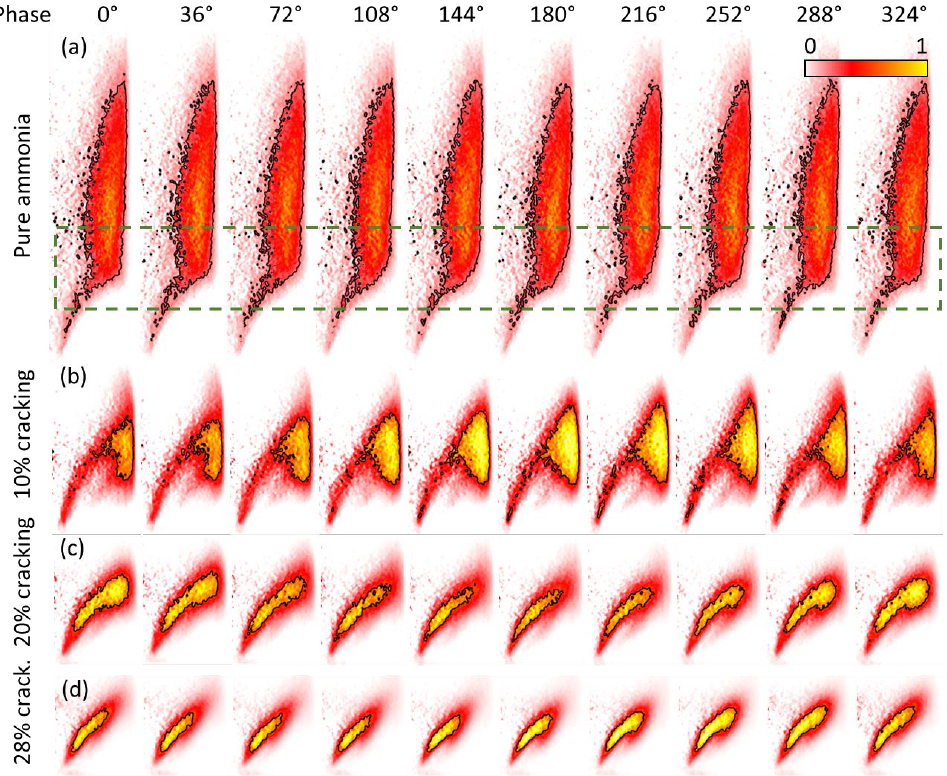
Figure 10. Phase-locked Abel-deconvoluted images of the OH* chemiluminescence for the four flames of Figure 1 (( a ) pure ammonia flame, ( b ) flame of ammonia at 10% cracking, ( c ) flame of ammonia at 20% cracking, and ( d ) flame of ammonia at 28% cracking), subjected to acoustic forcing at 192 Hz, with a forcing amplitude of 10%. The black isolines correspond to 25% intensity for the pure ammonia flame and 50% intensity for the partly cracked ammonia